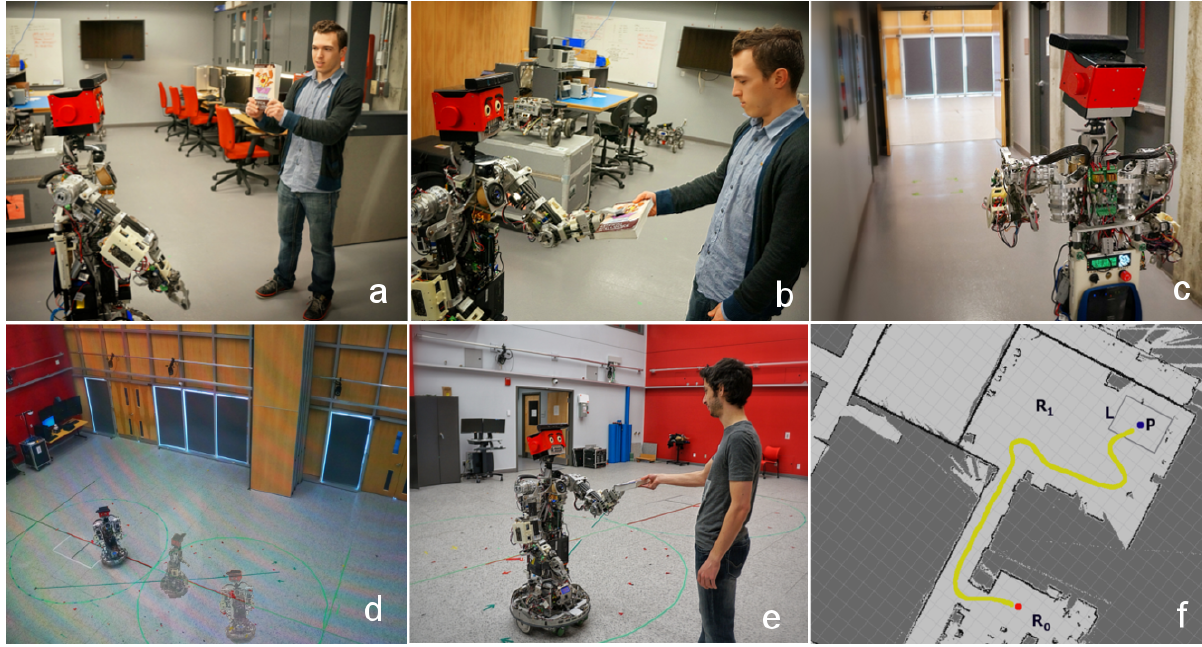
Figure 6: IRL-1/TR doing a fetch-and-deliver task: a) IRL-1/TR identifies a person and an object in a room; b) IRL-1/TR asks the person to give the object to its gripper; c) IRL-1/TR navigates autonomously to another room; d) IRL-1/TR wanders around, looking for somebody to deliver the object to; e) IRL-1/TR has found someone and gives the object; f) Top view illustration of the fetch-and-deliver task where the destination is a location in the second room.